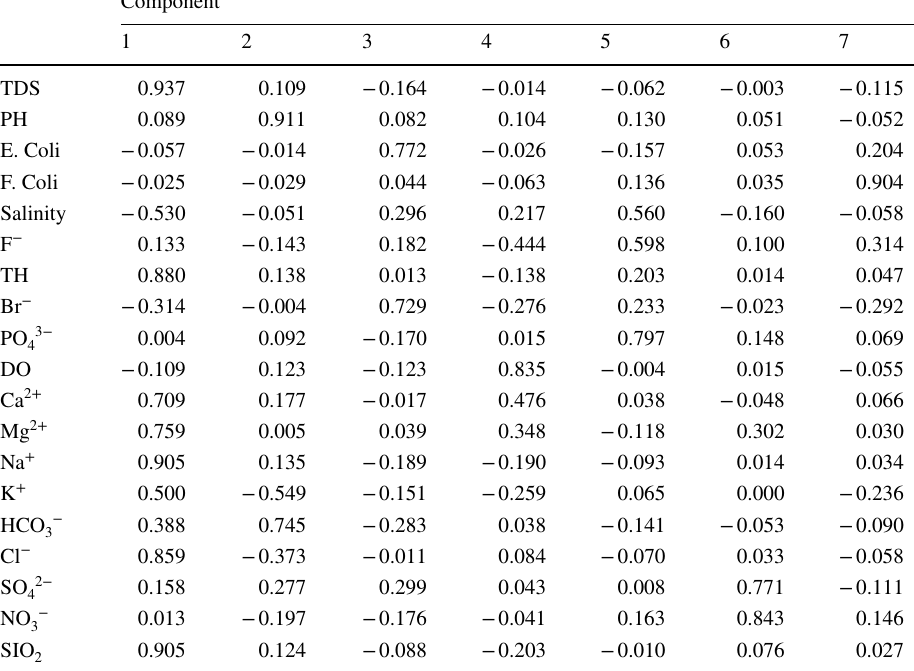
Fig. 3 Scree plot showing the Eigenvalues of the various